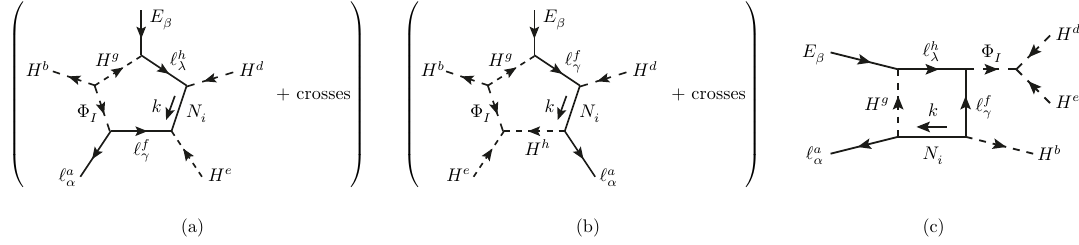
Figure 5 . The 1LPI diagrams with external lines generated by the (cid:0) ‘EH † HH (cid:1) field configuration in the type-(I+II) seesaw